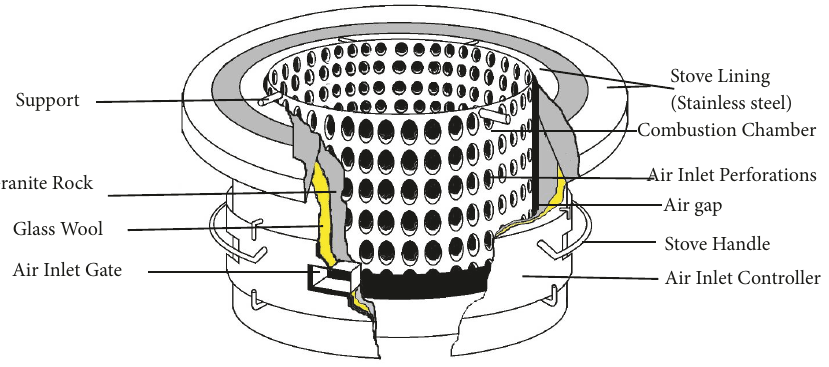
Figure 4: Major components of the